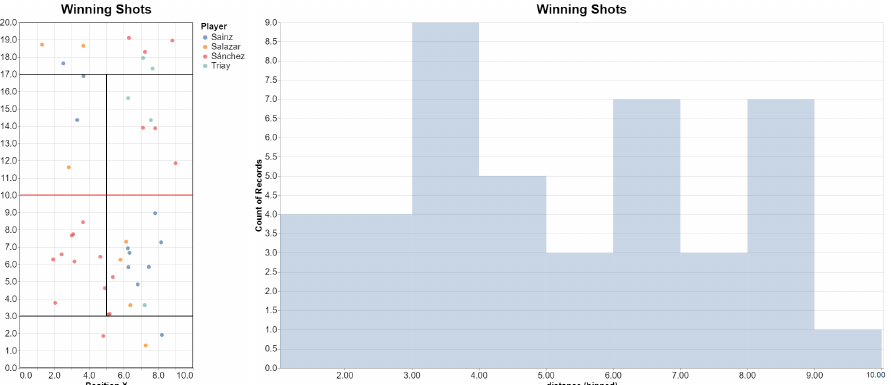
Figure 18. Position of the players (and distance to the net) at the moment they played the winning shot, for our test